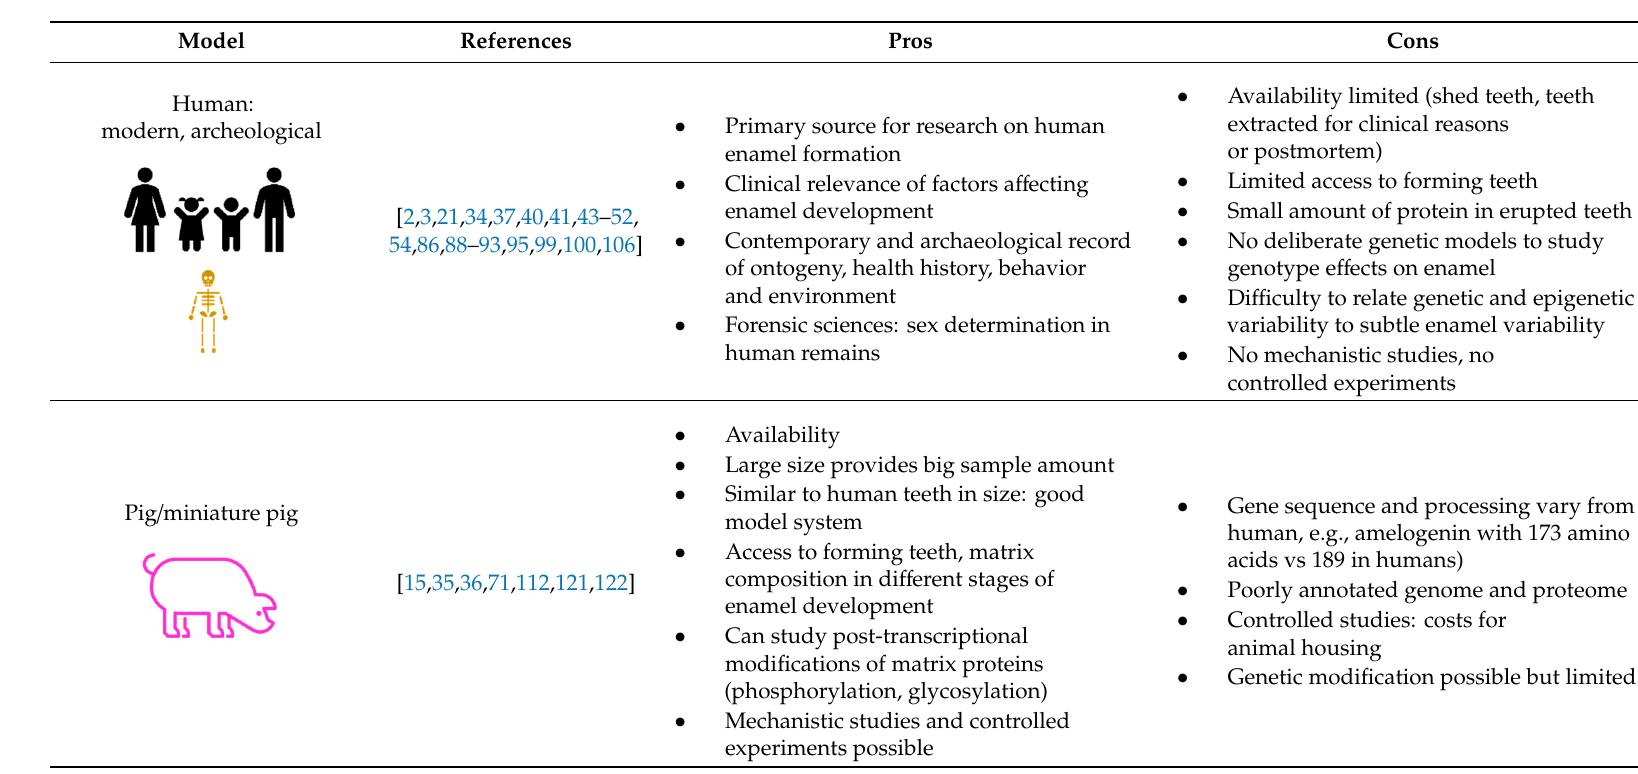
Table 3. Summary of pros and cons of the species for research on tooth enamel. Per model, the most prominent pros and cons on the models covered in this review are